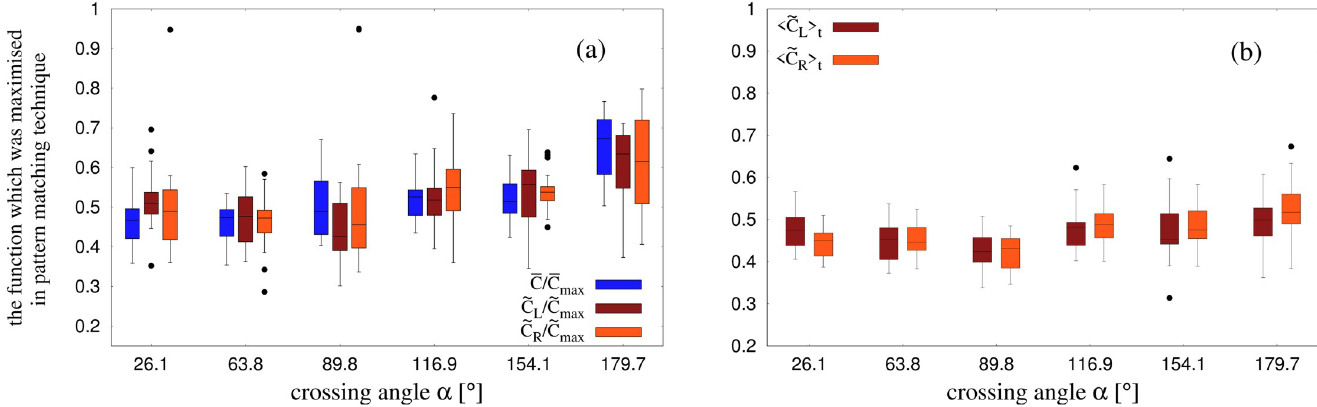
Fig 13. Boxplots for the maximising function of pattern matching technique. (a) Boxplots for � C = � C matching procedure of whole-crowd analysis and ~ C is the same with separate group-analysis. � C functions in these two cases, which are 2 and 1 respectively. (b) Boxplots for the time-averaged values of ~ C